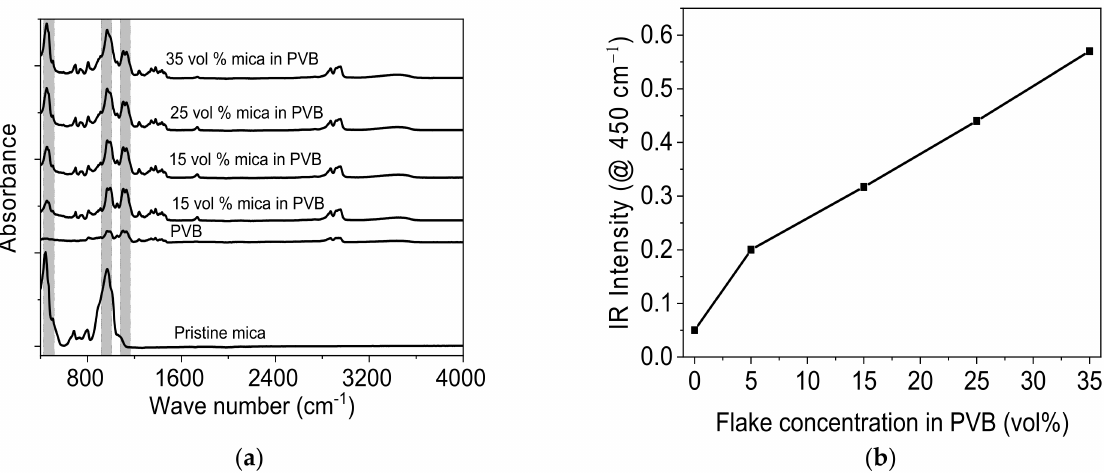
Figure 2. FTIR spectra of PVB filled with mica at different concentrations. ( a ) Spectra of mica powder and layers pristine PVB and PVB filled with 5–35 vol% mica. ( b ) IR peak intensity at 450 cm − 1 wave number, which shows linear increase with increasing mica concentration (5–35 vol%) in PVB.